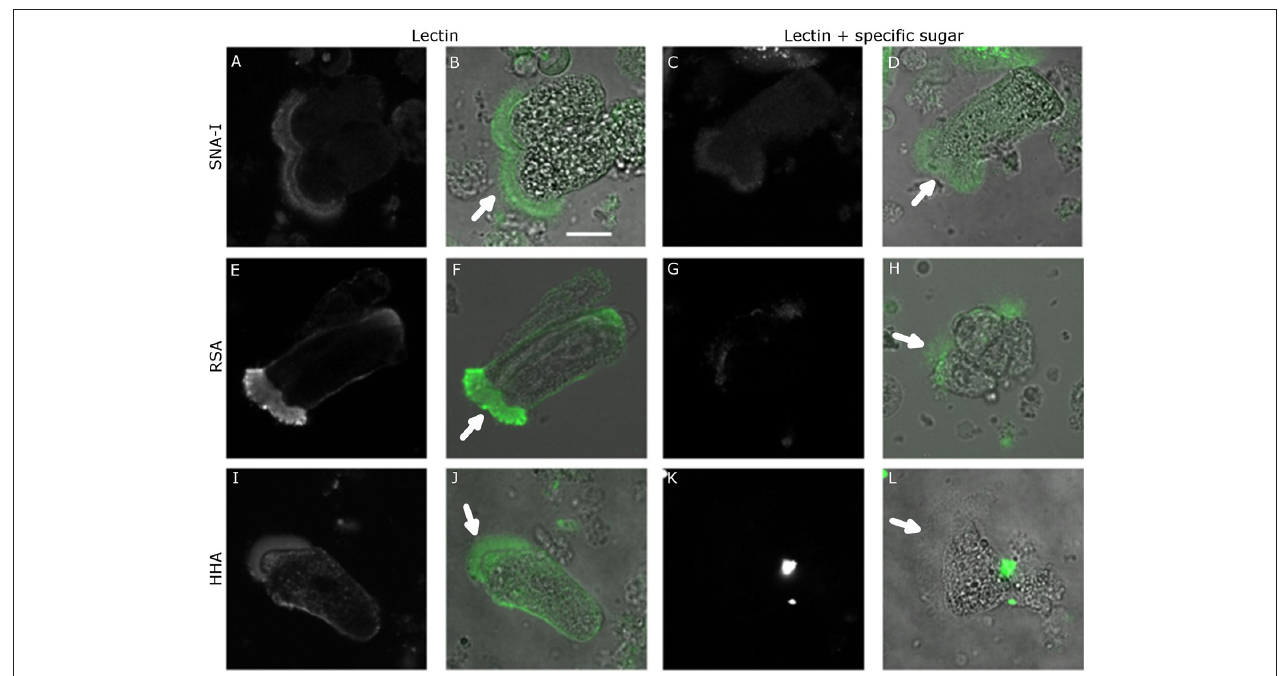
FIGURE 2 | Lectin binding specificity. Confocal microscopy images of FITC-labeled lectin binding to the surface of the midgut columnar cells of Spodoptera littoralis after pre-incubation with competing carbohydrates. (A–D) Binding of SNA-I without (A,B) or after (C,D) pre-incubation with SiaLacNAc. (E–H) Binding of RSA without (E,F) or after (G,H) pre-incubation with GalNAc. (I–L) Binding of HHA without (I,J) or after (K,L) pre-incubation with yeast mannans. In each case competing carbohydrates reduced the lectin binding, indicating that the lectin binding was mediated by glycans present on the surface of the midgut cells. Scale bar is 20 µ m. The arrows indicate the apical microvilli.